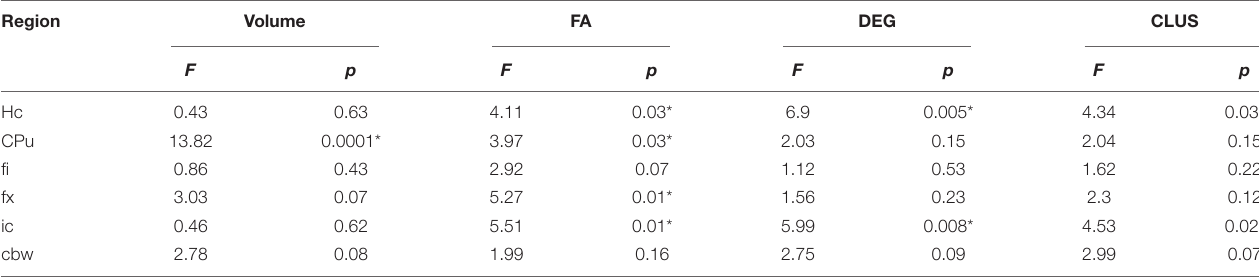
TABLE 2 | APOE genotype differences in MRI metrics i.e., volume, fractional anisotropy (FA), degree of connectivity (DEG), and clustering coefficient (CLUS) for regions of interest including: hippocampus (Hc), caudate putament (CPu), fimbria (fi), fornix (fx), internal capsule (ic), and cerebellar white matter (cbw). Region Volume FA DEG